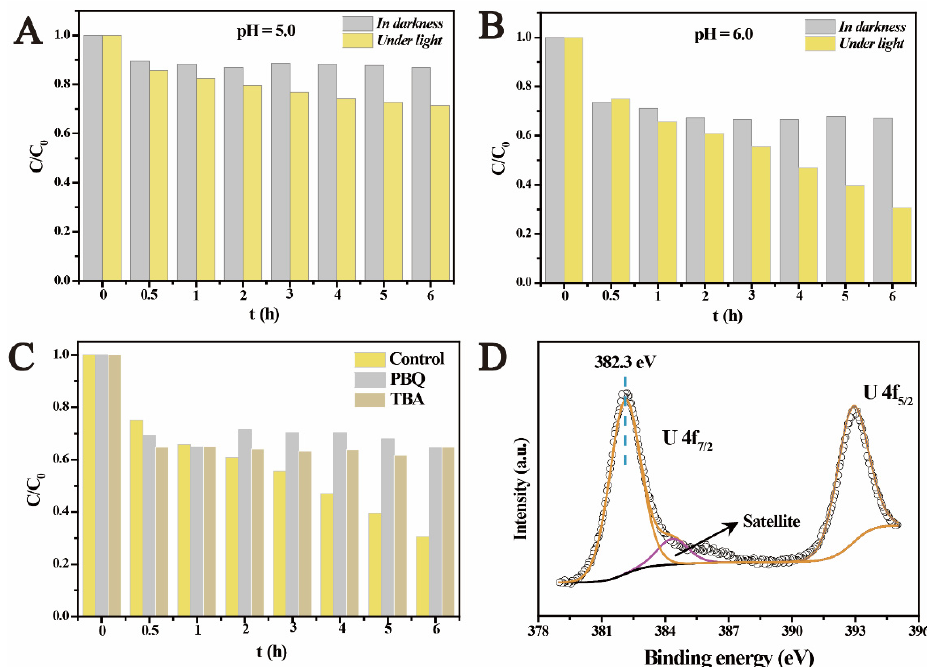
Figure 4. The photocatalysis of U(VI) by ferrihydrite in open air at pH 5.0 ( A ) and 6.0 ( B ), free radicals capture experiments under aerobic conditions ( C ), and U 4f spectrum of the obtained products for the photocatalysis of U(VI) in air ( D ).